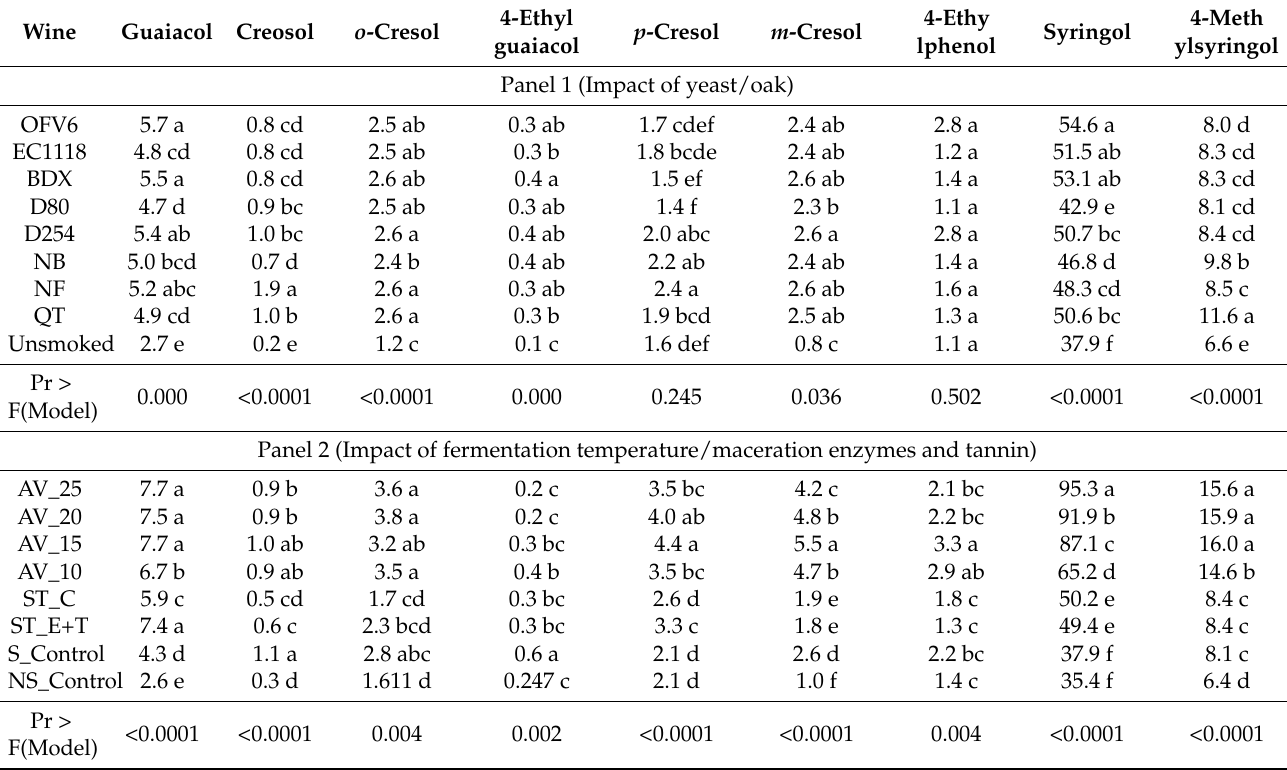
Table 2. Table 2. Total (free + bound) volatile phenol profiles of different wine treatments (n = 6, α ≤ 0.05). All concentrations are in µ